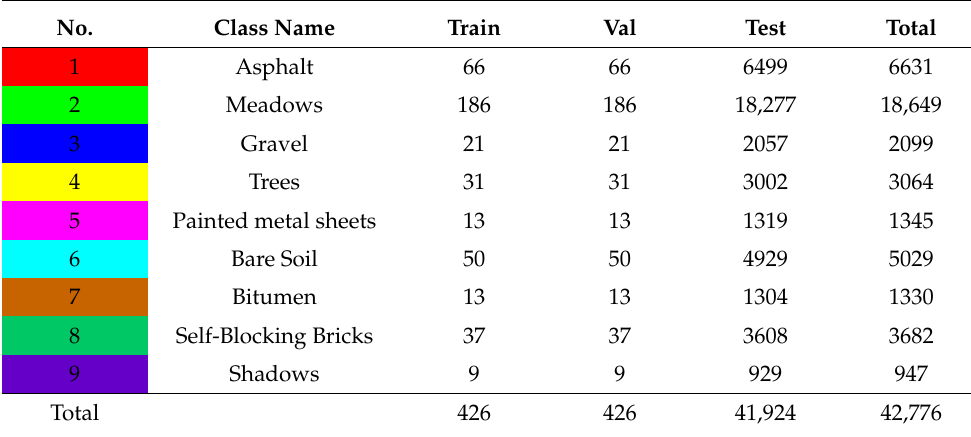
Table 1. Training validation and testing sample numbers in